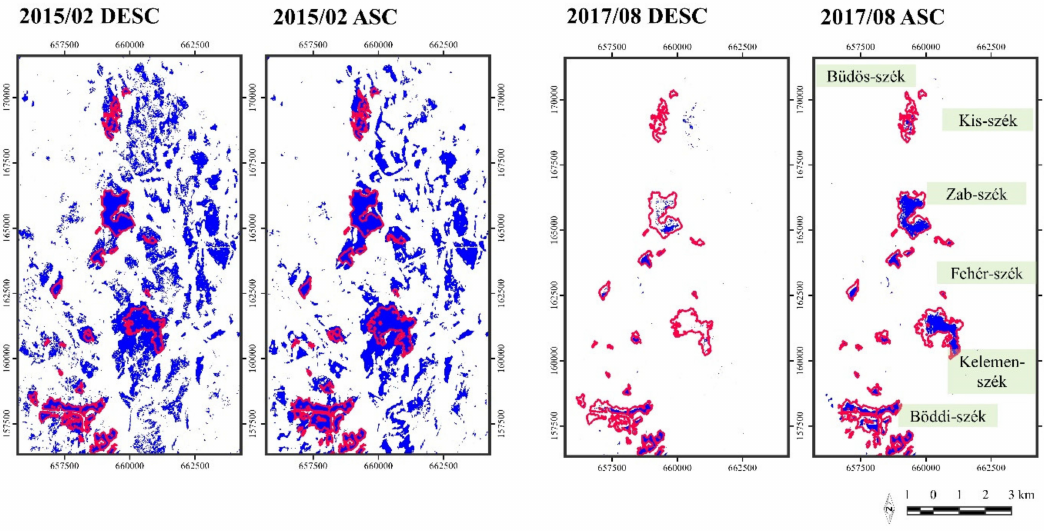
Figure 7. Water cover maps: the peak coverage as of February 2015 and the minimum coverage as of August 2017. DESC: descending path; ASC: ascending path; the average boundaries of the largest water patches / lakes for the examined period are depicted using red